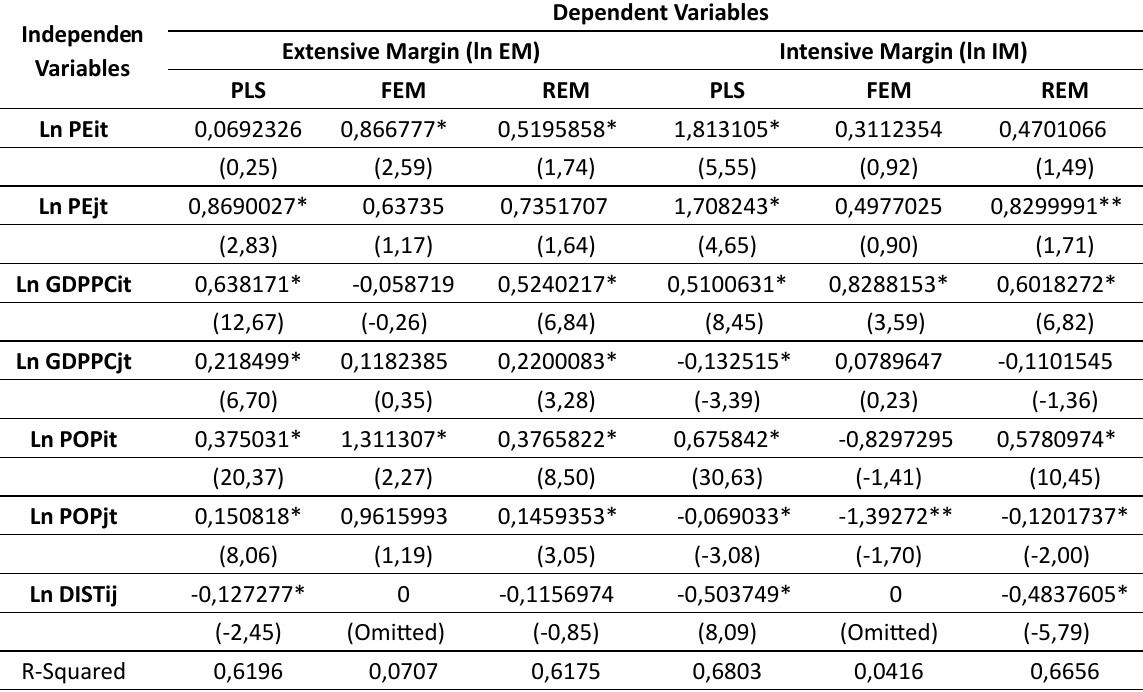
Table 1: Regression Results PLS, FEM, and